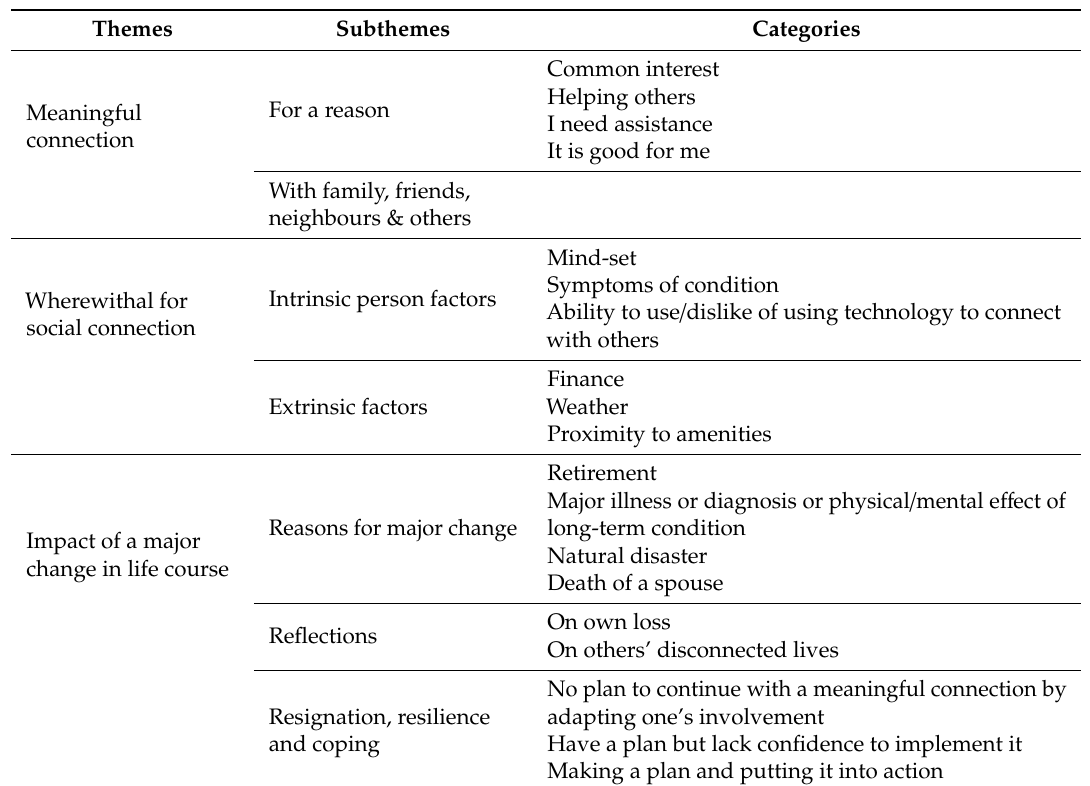
Table 3. Summary of themes, subthemes and